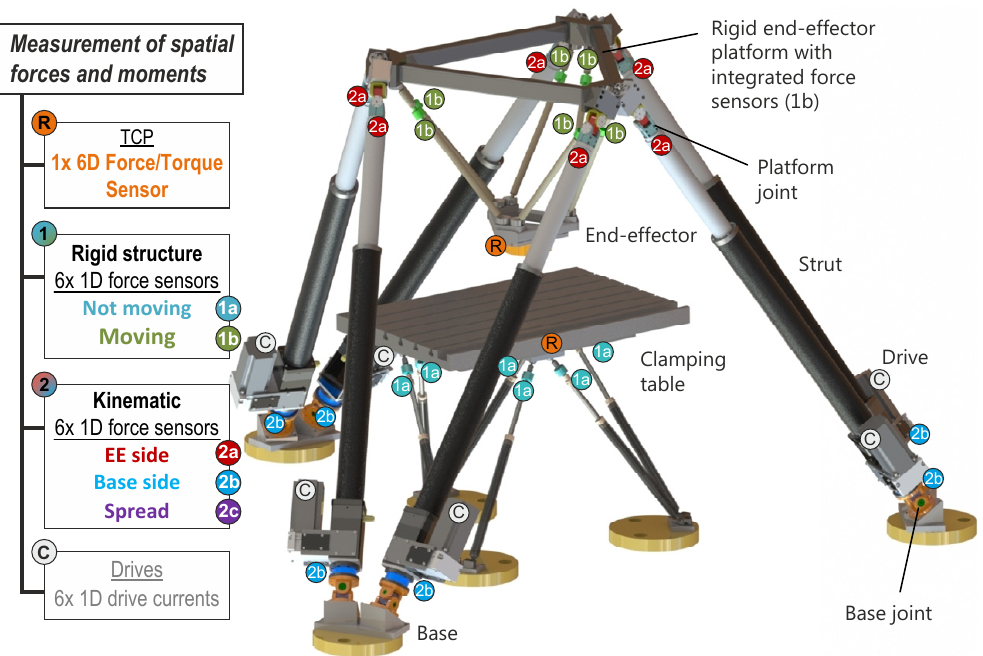
Figure 1. Force sensor integration into hexapod structures and kinematics: approach and sensor placement; 1a: Rigid not moving hexapod structure (e.g., clamping table), 1b: Rigid moving hexapod structure (e.g., end-effector platform), 2x: Hexapod kinematics with sensors in the struts at various positions